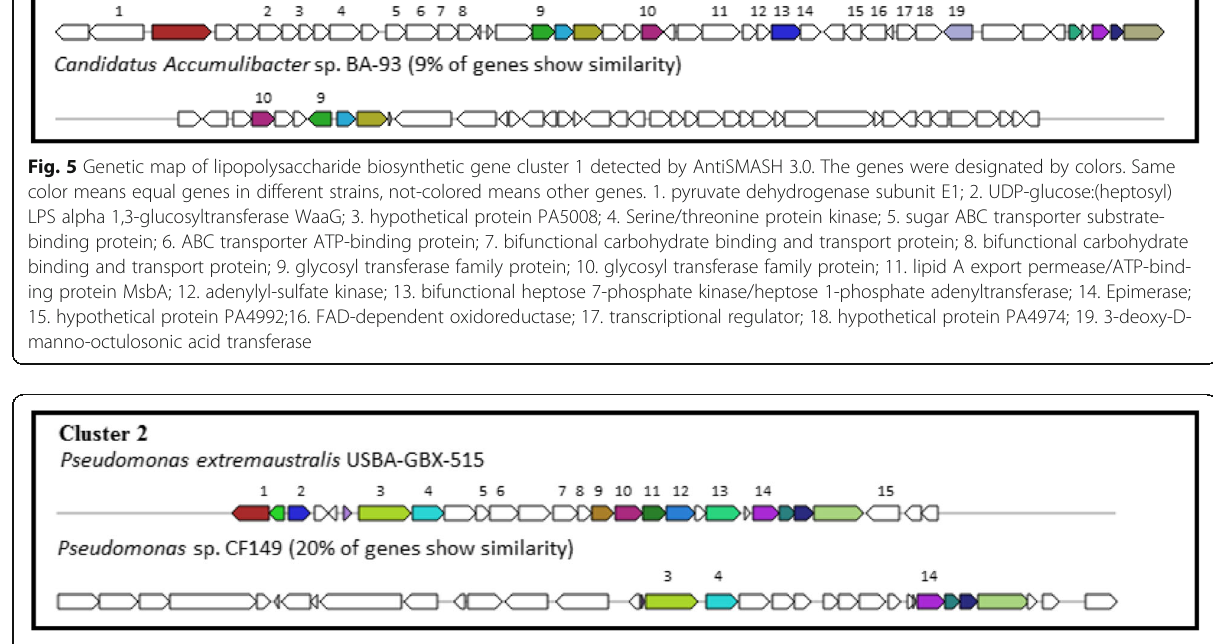
Fig. 6 Genetic map of colanic acid biosynthetic gene cluster 2 detected by AntiSMASH 3.0. The genes were designated by colors. Same color means equal genes in different strains; not colored means other genes. 1. Thiosulfate sulfurtransferase; 2. transcriptional regulator; 3. nucleotide sugar dehydrogenase; 4. colanic acid production tyrosine-protein kinase; autokinase; Ugd phosphorylase; 5 – 7. hypothetical protein; 8. putative acyl transferase; 9. Glycosyl transferase; 10. GDP-D-mannose dehydratase, NAD(P)-binding; 11. bifunctional GDP-fucose synthetase: GDP-4-dehydro-6-deoxy-D-mannose epimerase/ GDP-4-dehydro-6-L- deoxygalactose reductase; 12. colanic acid biosynthesis glycosyl transferase WcaI; 13. mannose-1-phosphate guanylyltransferase/mannose-6-phosphate isomerase